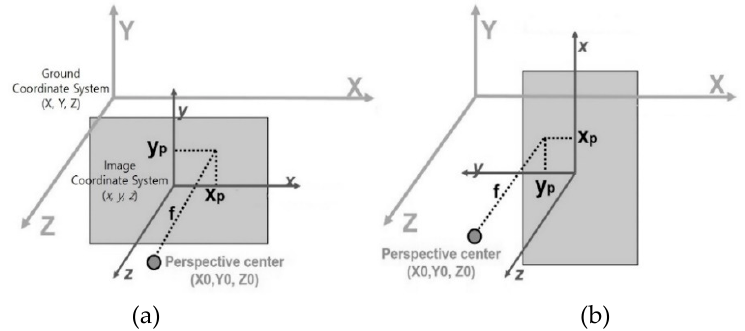
Figure 1. Ground and image coordinate system when ( a ) κ = 0 ˚ , ( b ) κ = 90 ˚ Figure 2. Ground and image coordinate system when ( a ) κ = 0 ◦ , ( b ) κ = 90 ◦